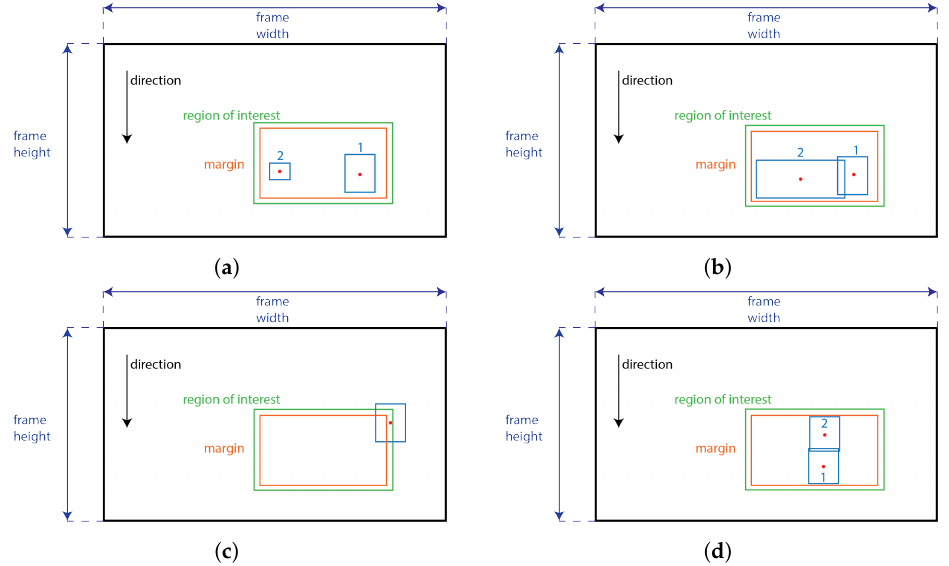
Figure 7. Situations appearing in the proposed approach. ( a ) Incorrectly detected object is too small; ( b ) incorrectly detected object is too big; ( c ) object is only partially visible; ( d ) detection loss.